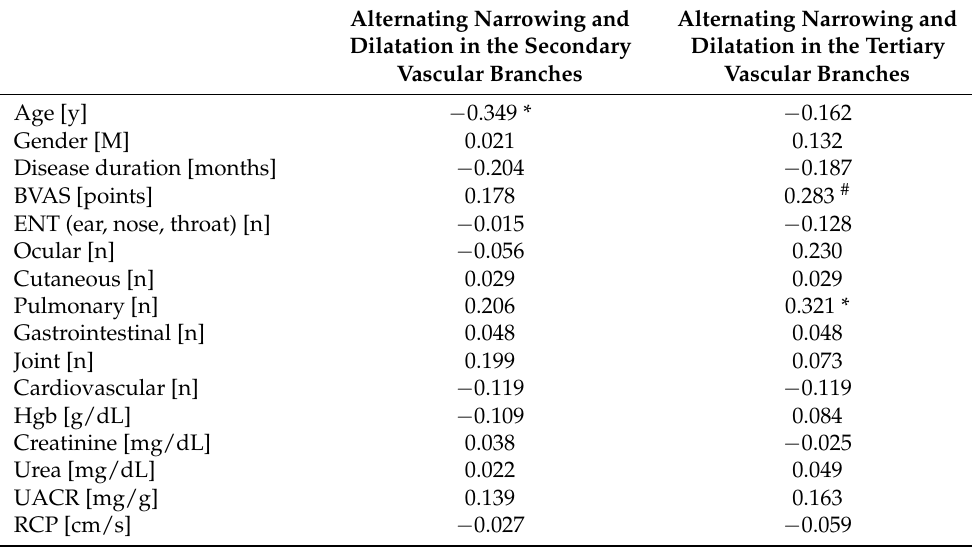
Table 5. Correlations between alternating narrowing and dilatation in secondary and tertiary vascular branches and clinical and blood test results.